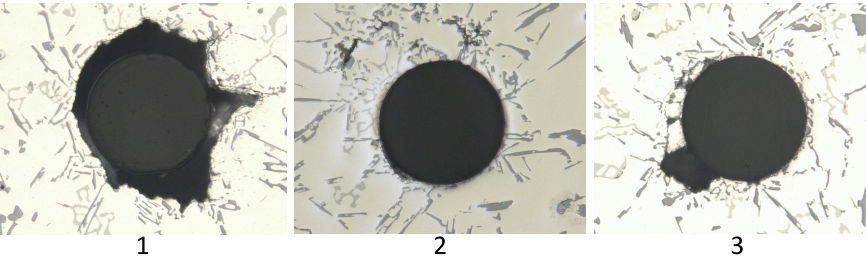
Figure 13. Cross-sections of three different probes where the fibre is located along the melt flow direction.